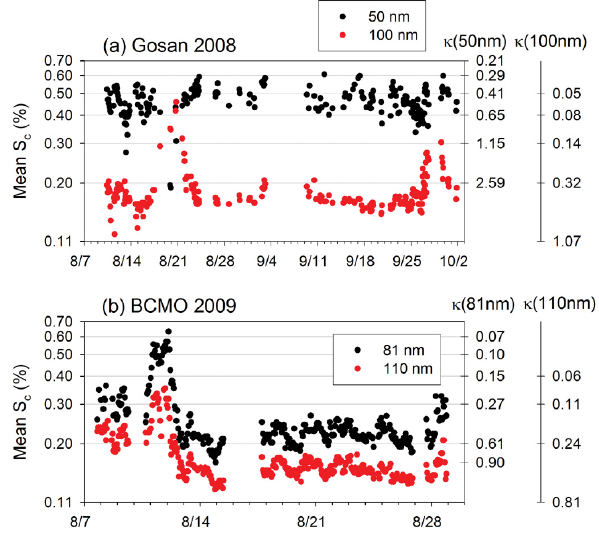
Fig. 8. Time plots of S c during Gosan 2008 (top) and BCMO 2009 (bottom). The κ values for corresponding S c values for each dry diameter are shown on the